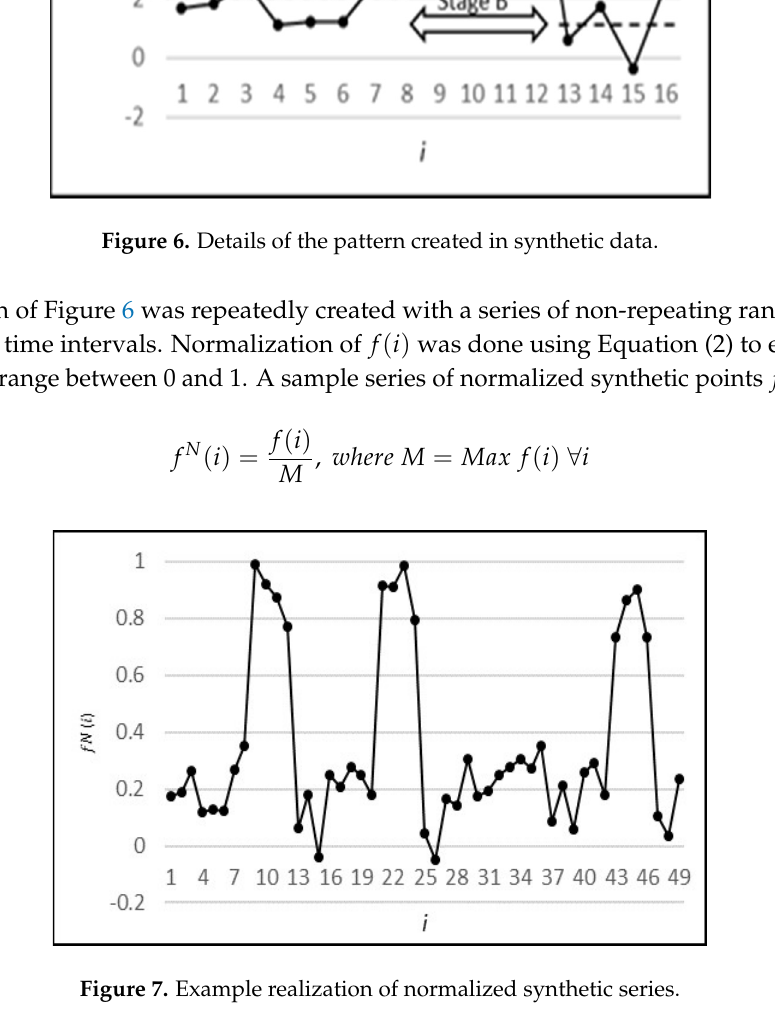
Figure 7. Example realization of normalized synthetic